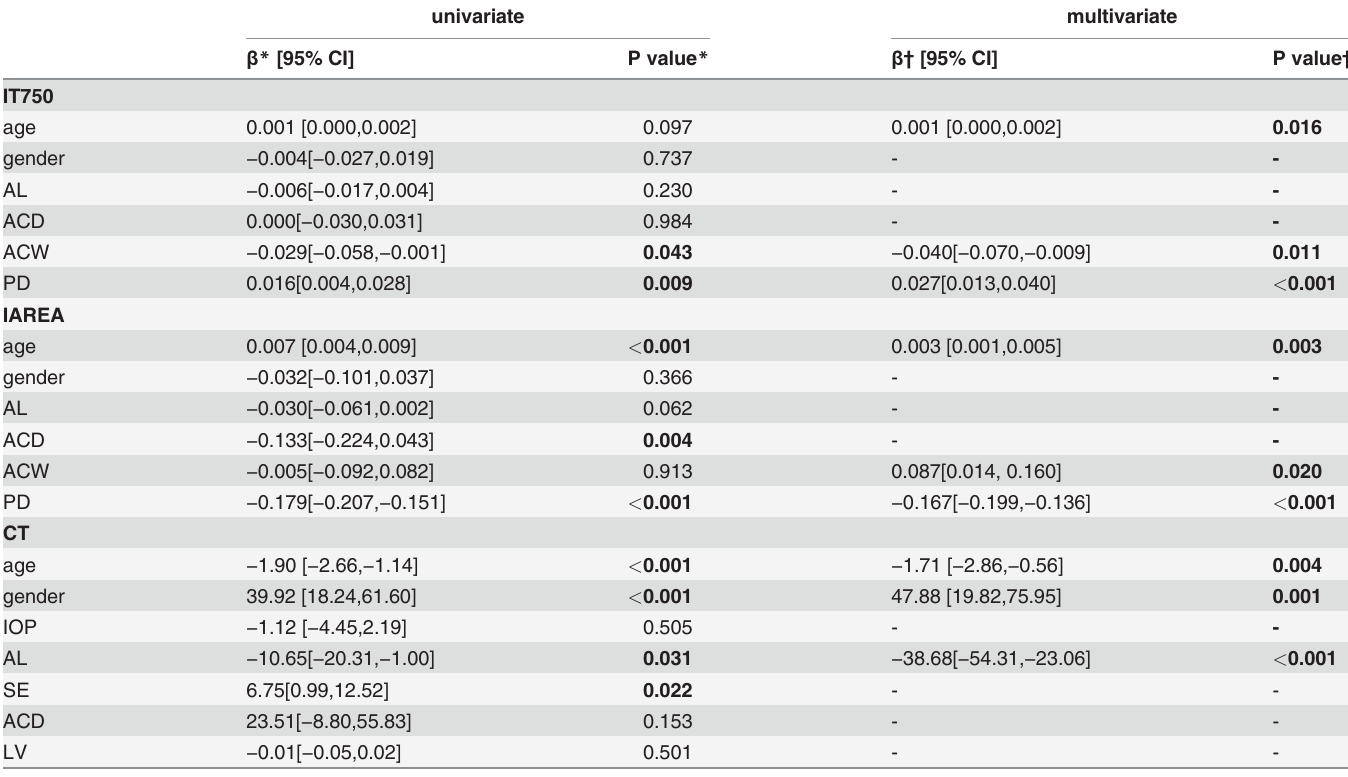
Table 2. Uni- and multivariate linear regression for associated baseline factors of iris thickness, iris area and choroidal thickness. univariate multivariate β * [95% CI] P value *